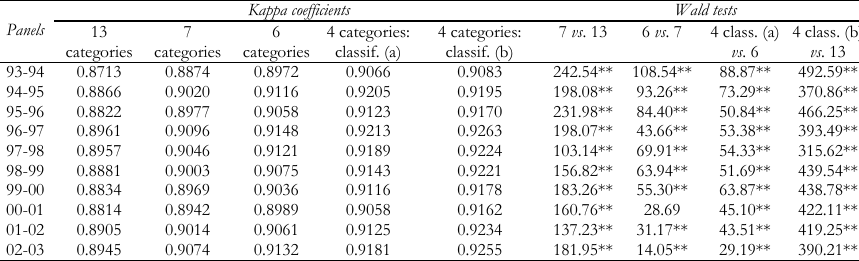
Hierarchical Kappa coefficients and Wald tests: joint classifications by professional status and